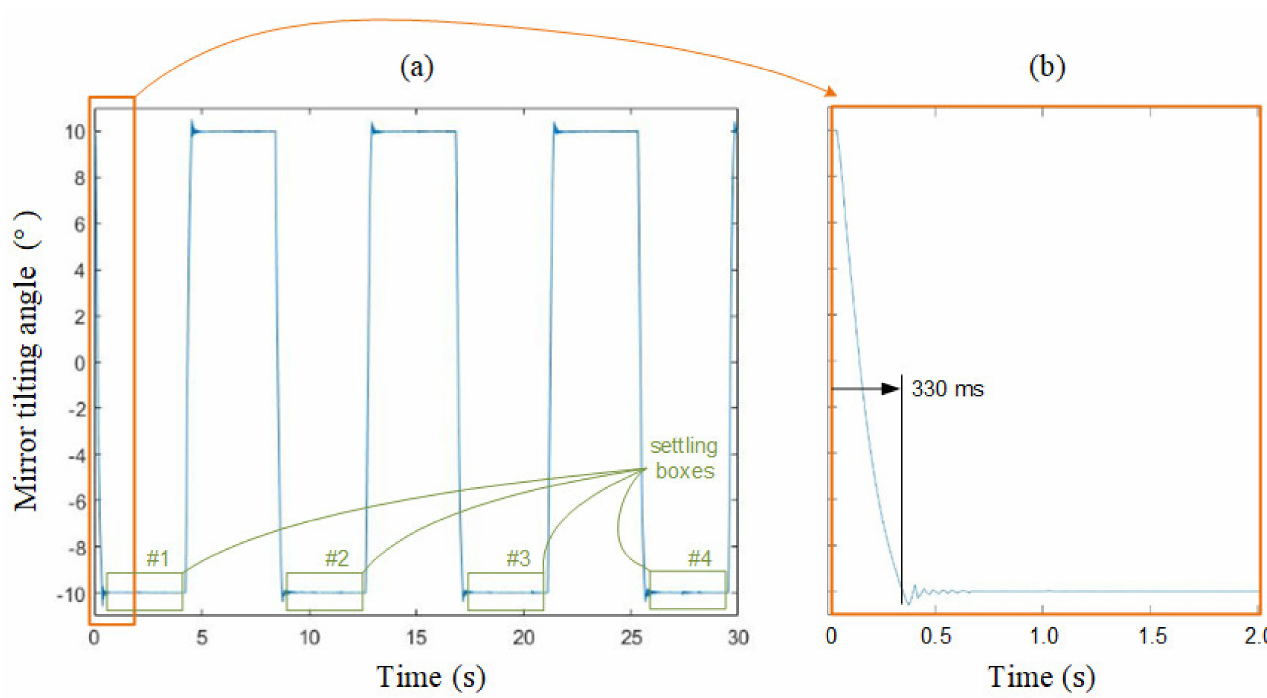
Figure 12. ( a ) Full scale regulation response of the proposed system. ( b ) The detailed view of settling